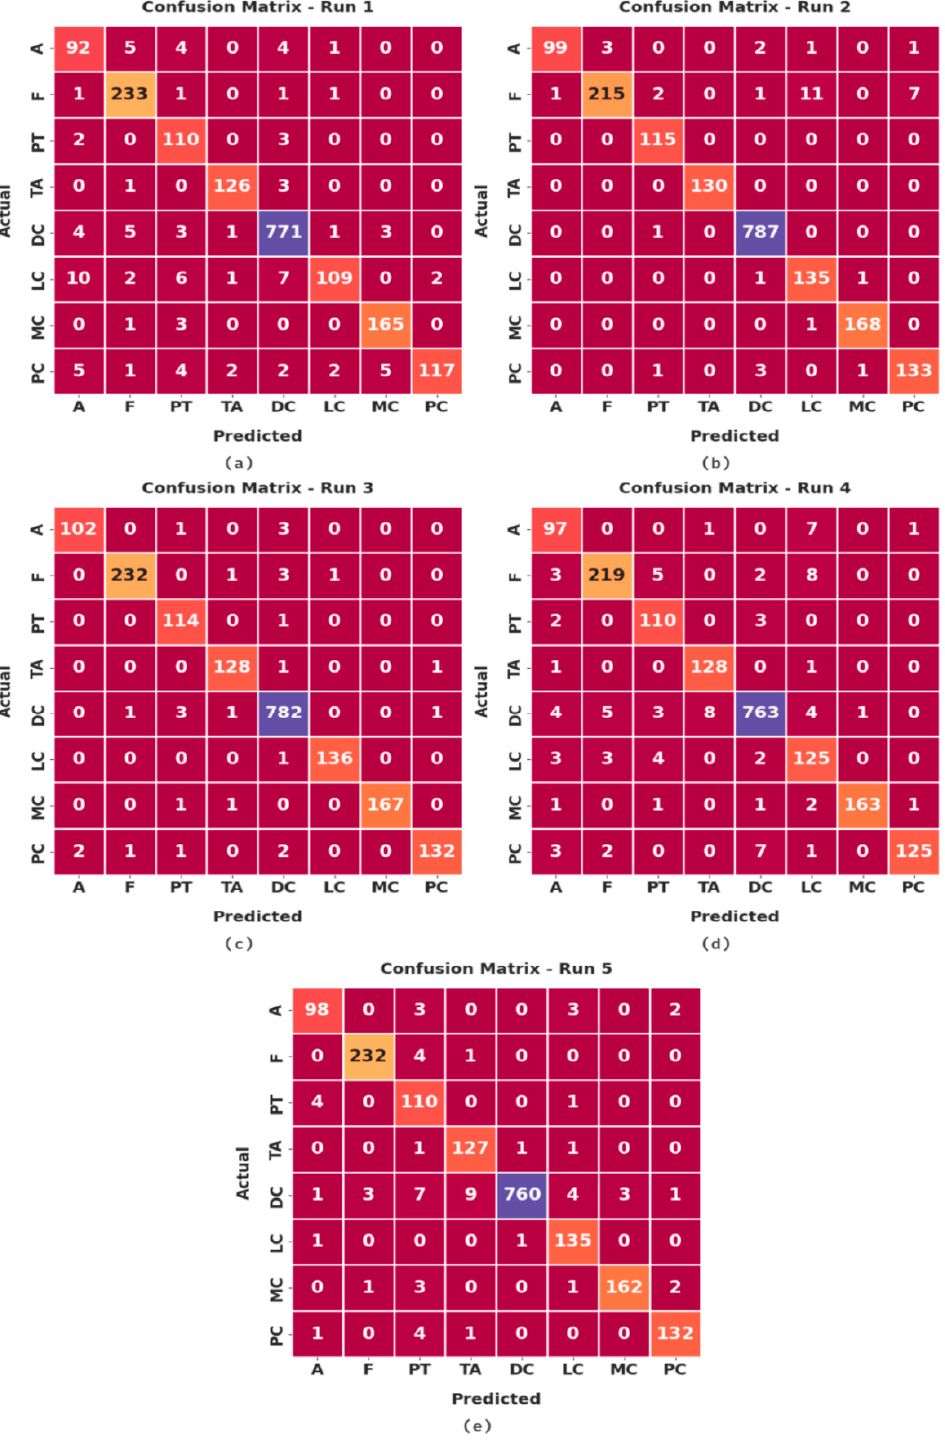
Figure 4. Confusion matrices of the proposed IBESSDL-BCHI approach; ( a ) Run 1, ( b ) Run 2, ( c ) Run 3, ( d ) Run 4, and ( e ) Run 5.